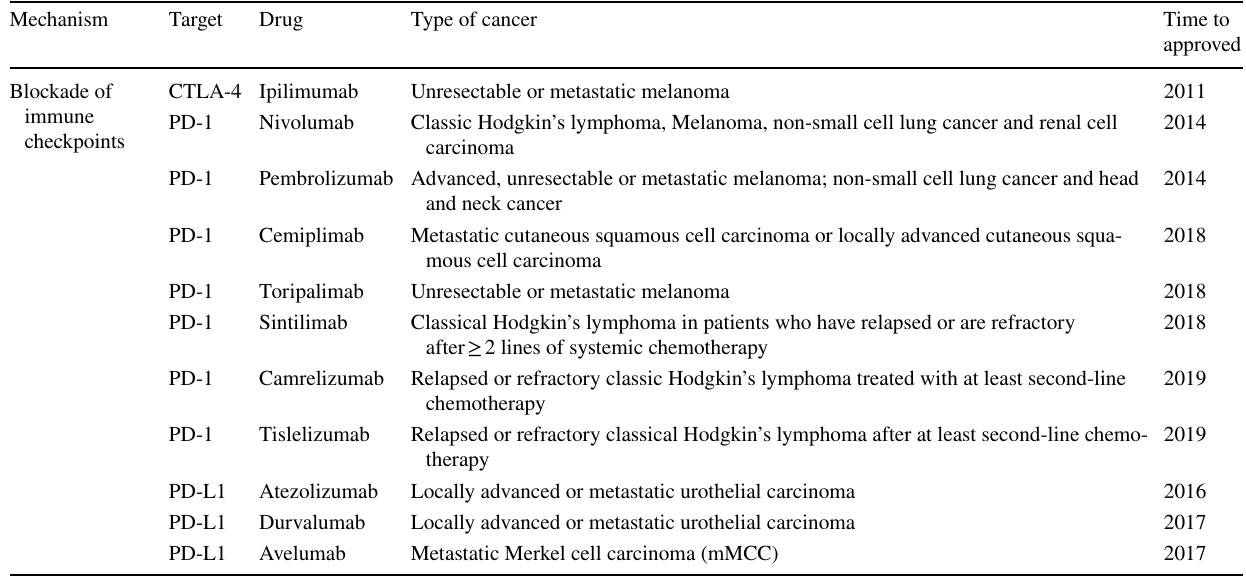
Table 1 Summary of therapeutic antibodies approved for cancer immunotherapy